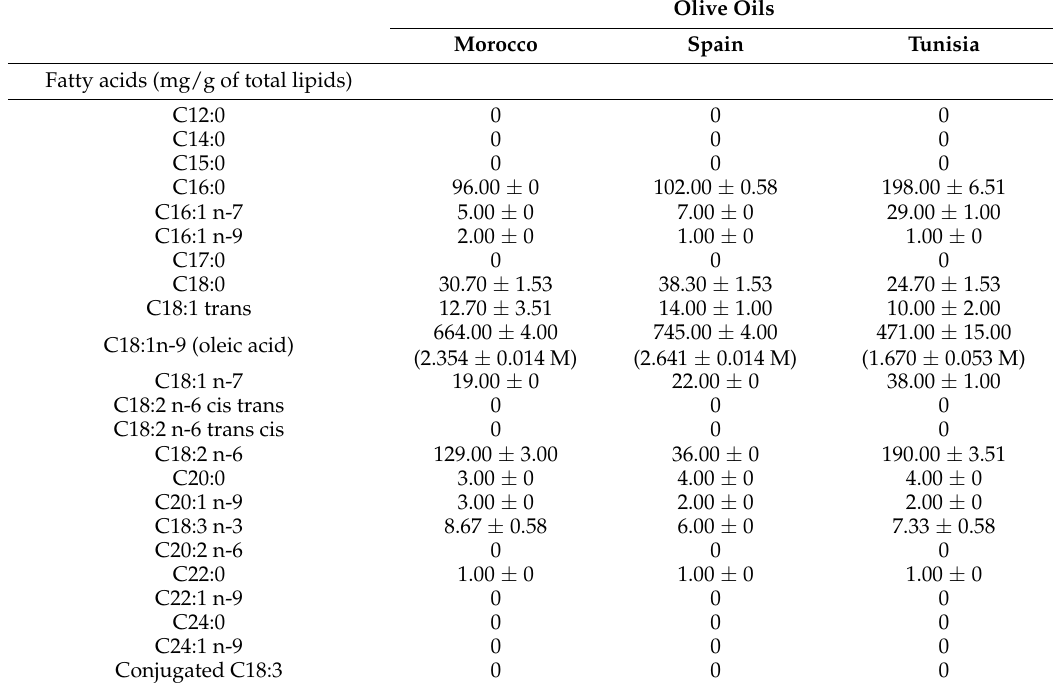
Table 1. Fatty acid and tocopherol content of olive oils.